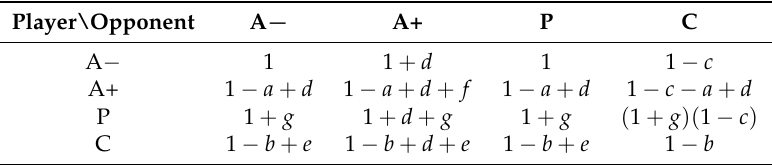
Table 2. Payoff matrix of four cancer cell